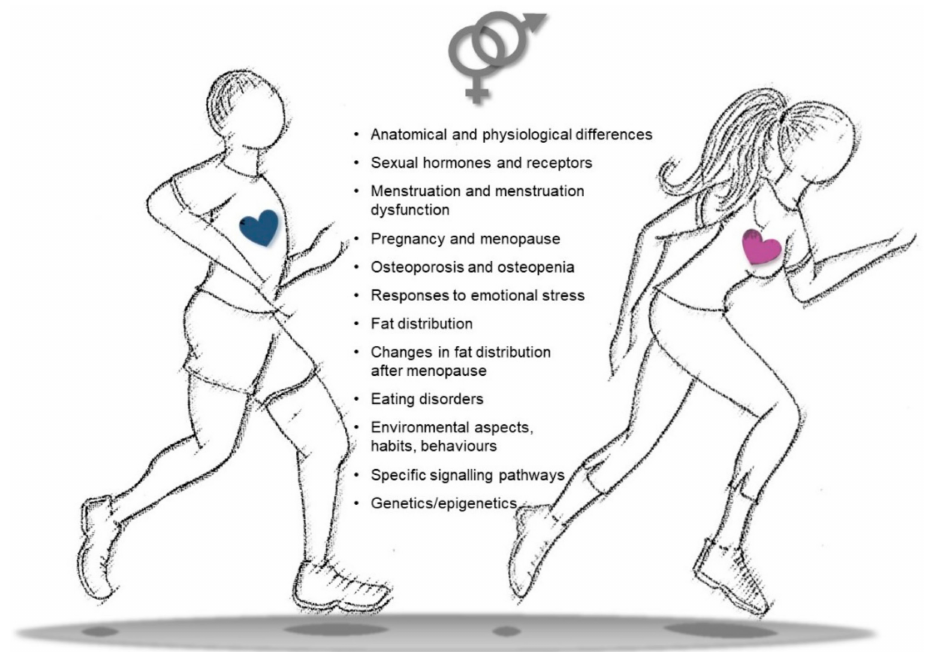
Figure 4. Snapshot of key di ff erences in sex / gender features to be considered in physical activity to improve cardiovascular health, decrease cardiovascular disease (CVD) risk, and settle personalized training / rehabilitative exercise